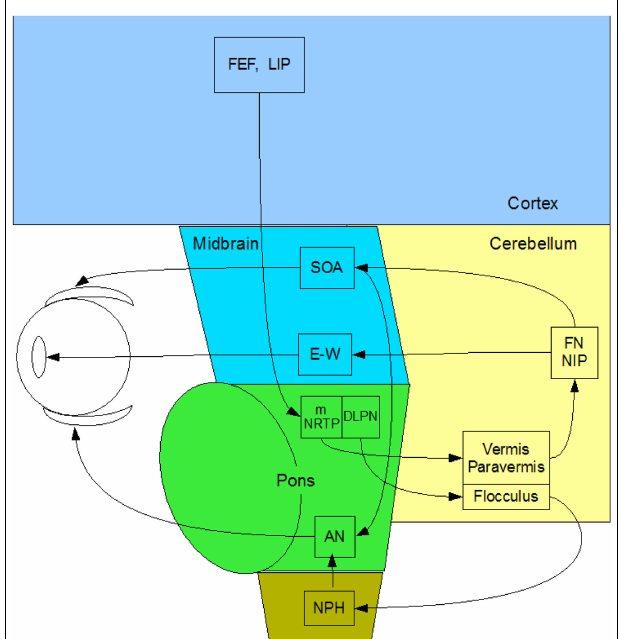
FIGURE 2 | Summary diagram of the subcortical pathways for vergence control pathways of the medial and lateral recti through the supra-oculomotor area (SOA) and abducens nuclei (AN), respectively, and of the ciliary muscle via the Edinger–Westphal nuclei (E–W), assembled by the present authors from Gamlin (13)